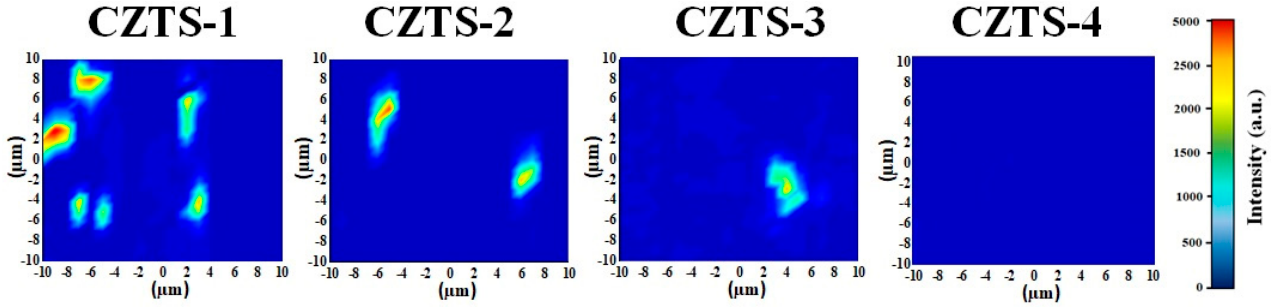
Figure 4. Raman mapping of CZTS − 1, CZTS − 2, CZTS − 3, and CZTS − 4. To confirm whether the sheet-like objects in the SEM images are SnS x phase, and to